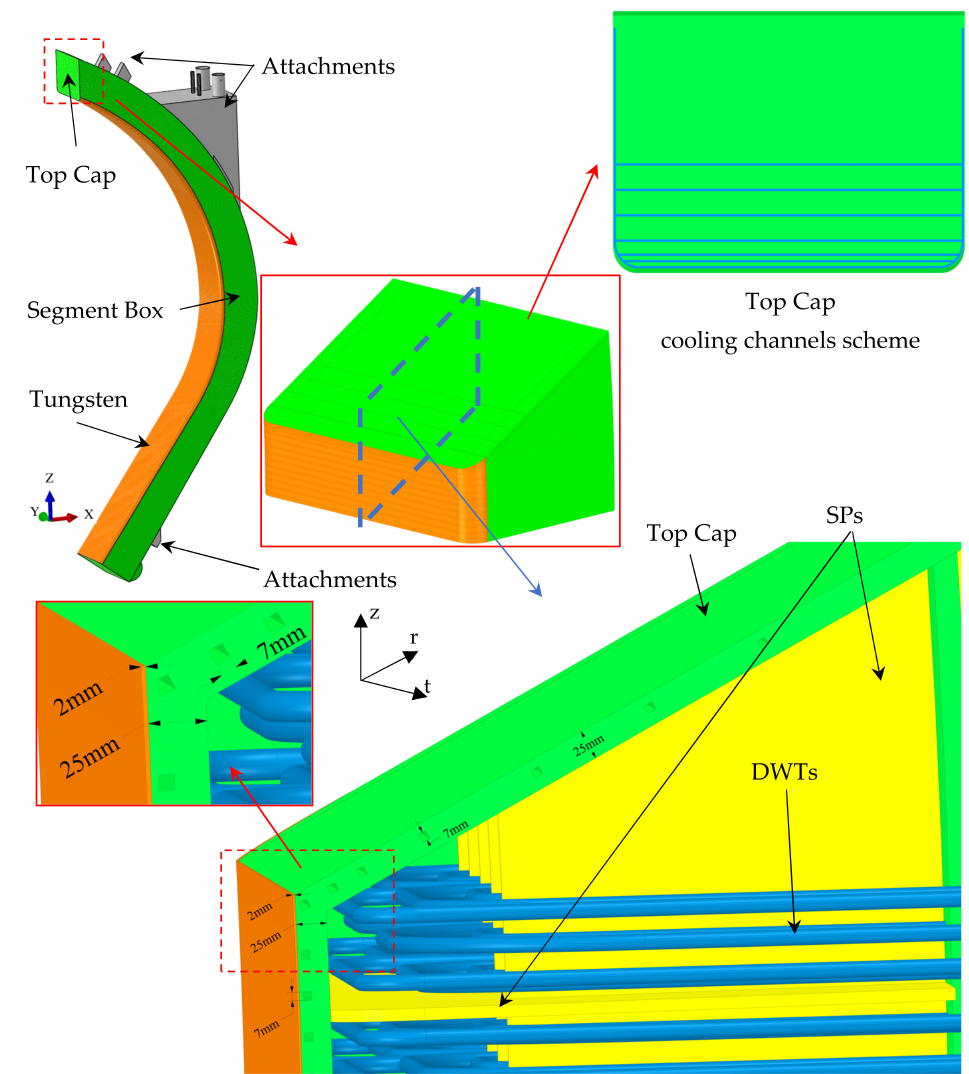
Figure 1. The top cap region reference geometric